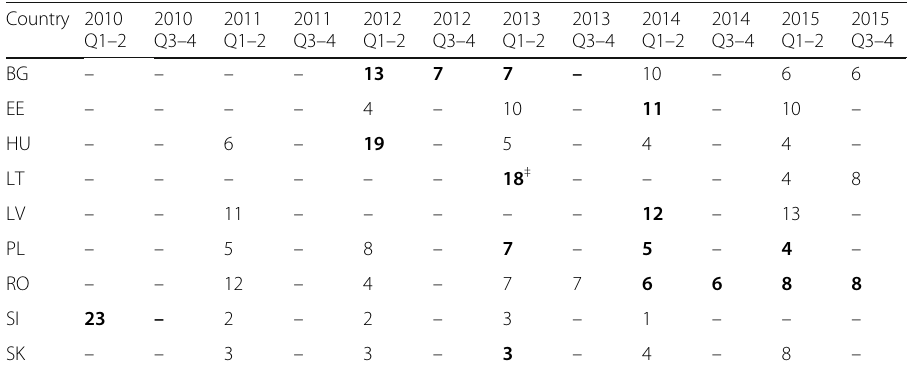
Table 3 Timing and size of rise in the minimum wage, % (period analysed in